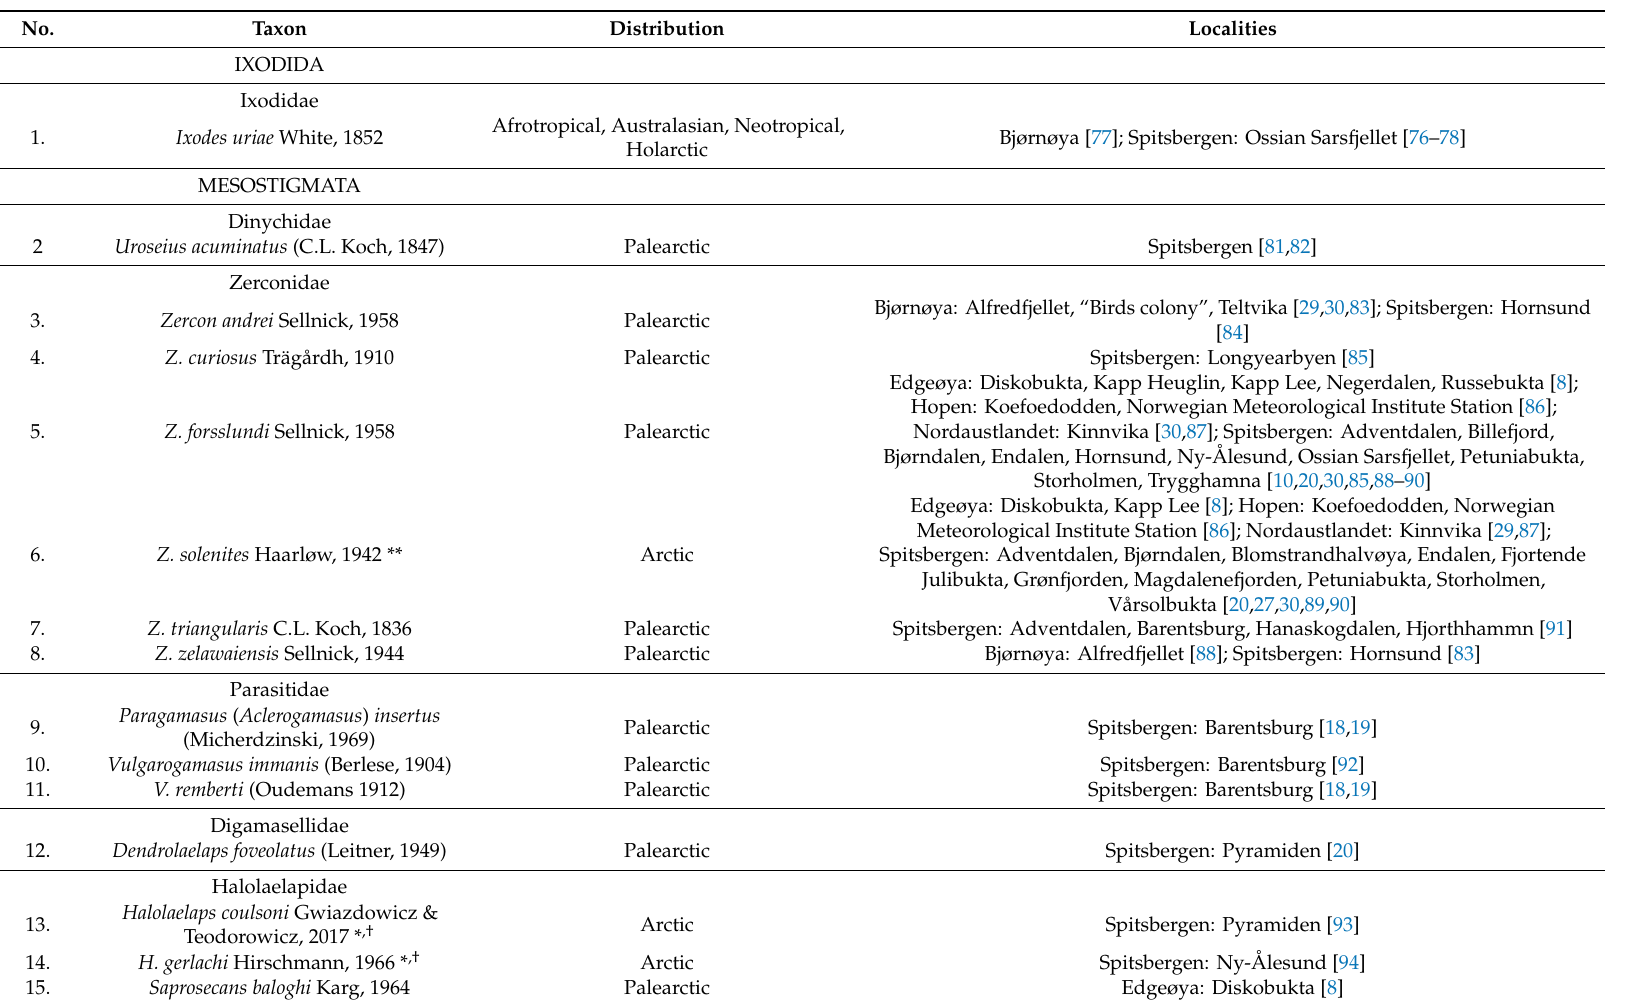
Table 1. List of mites of the Svalbard